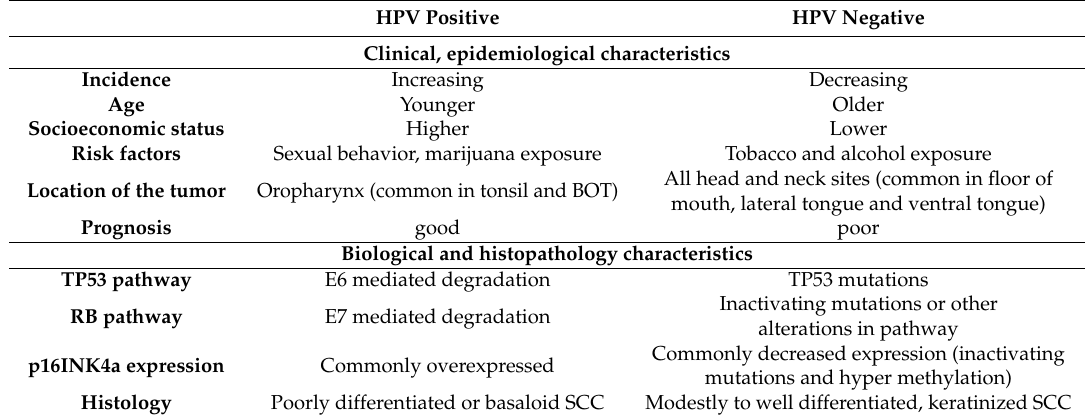
Table 1. Overview of clinical and biological differences between HPV positive and HPV negative head and neck cancer